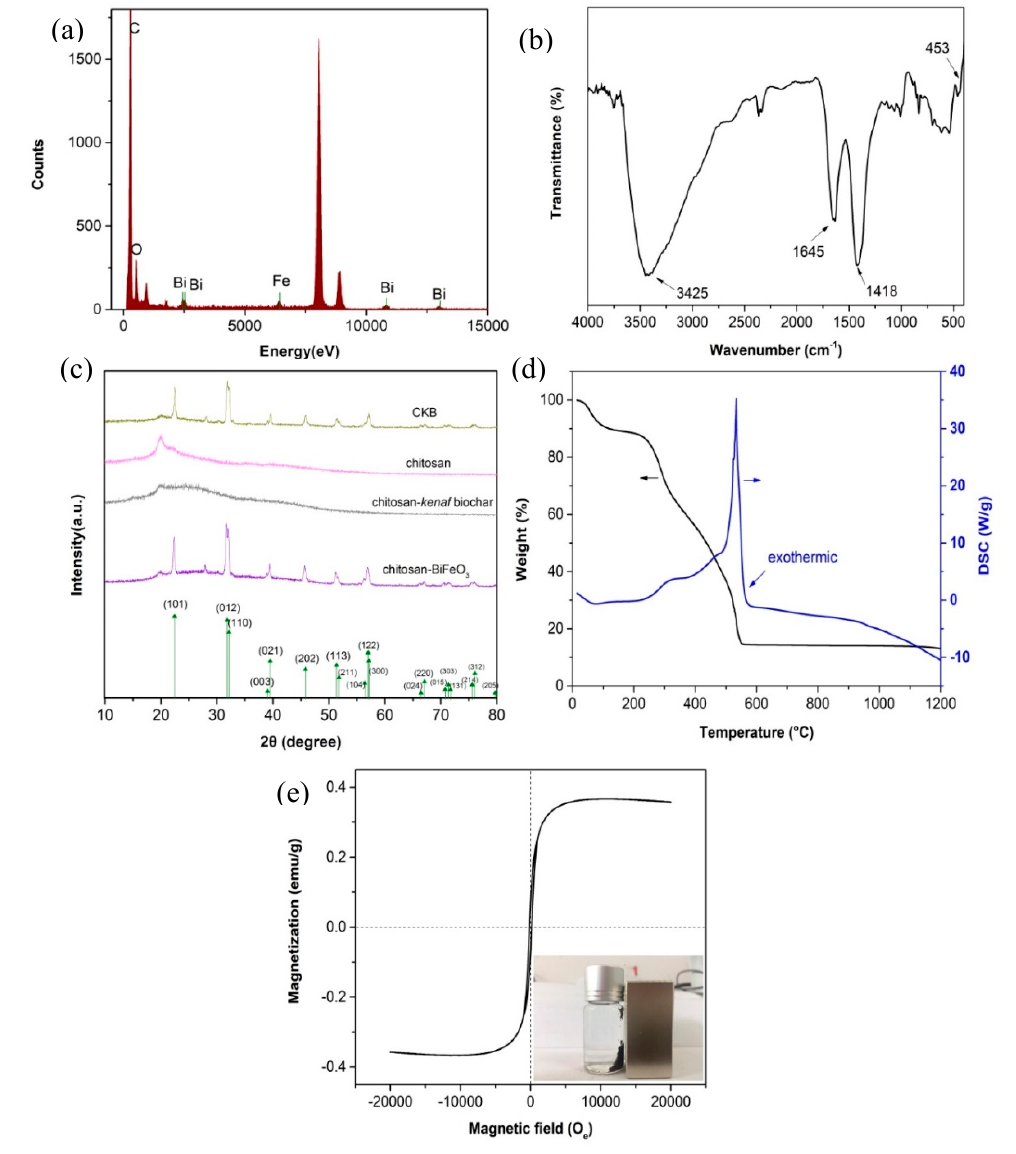
Figure 3. ( a ) EDS spectra of CKB, ( b ) FT-IR spectra of CKB, ( c ) XRD spectrum of chitosan, chitosan-BiFeO 3 , chitosan-kenaf biochar, and CKB, ( d ) TG-DSC of CKB, ( e ) magnetization curve of CKB.